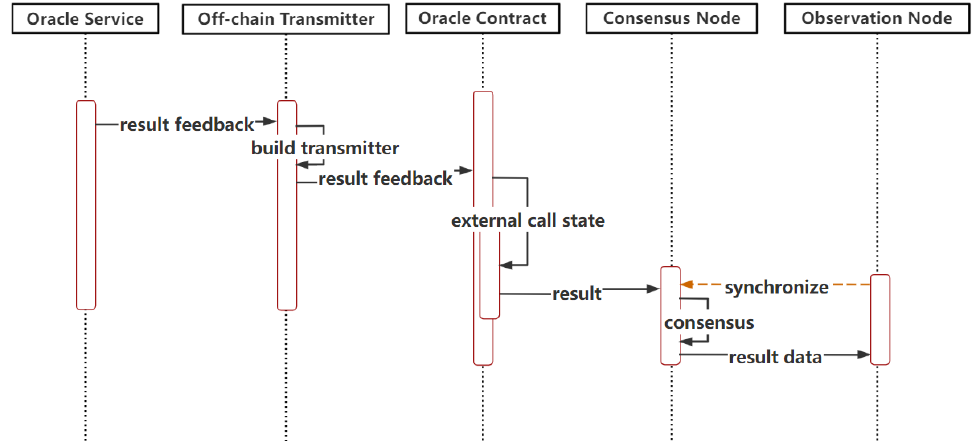
Figure 4. Push-based inbound